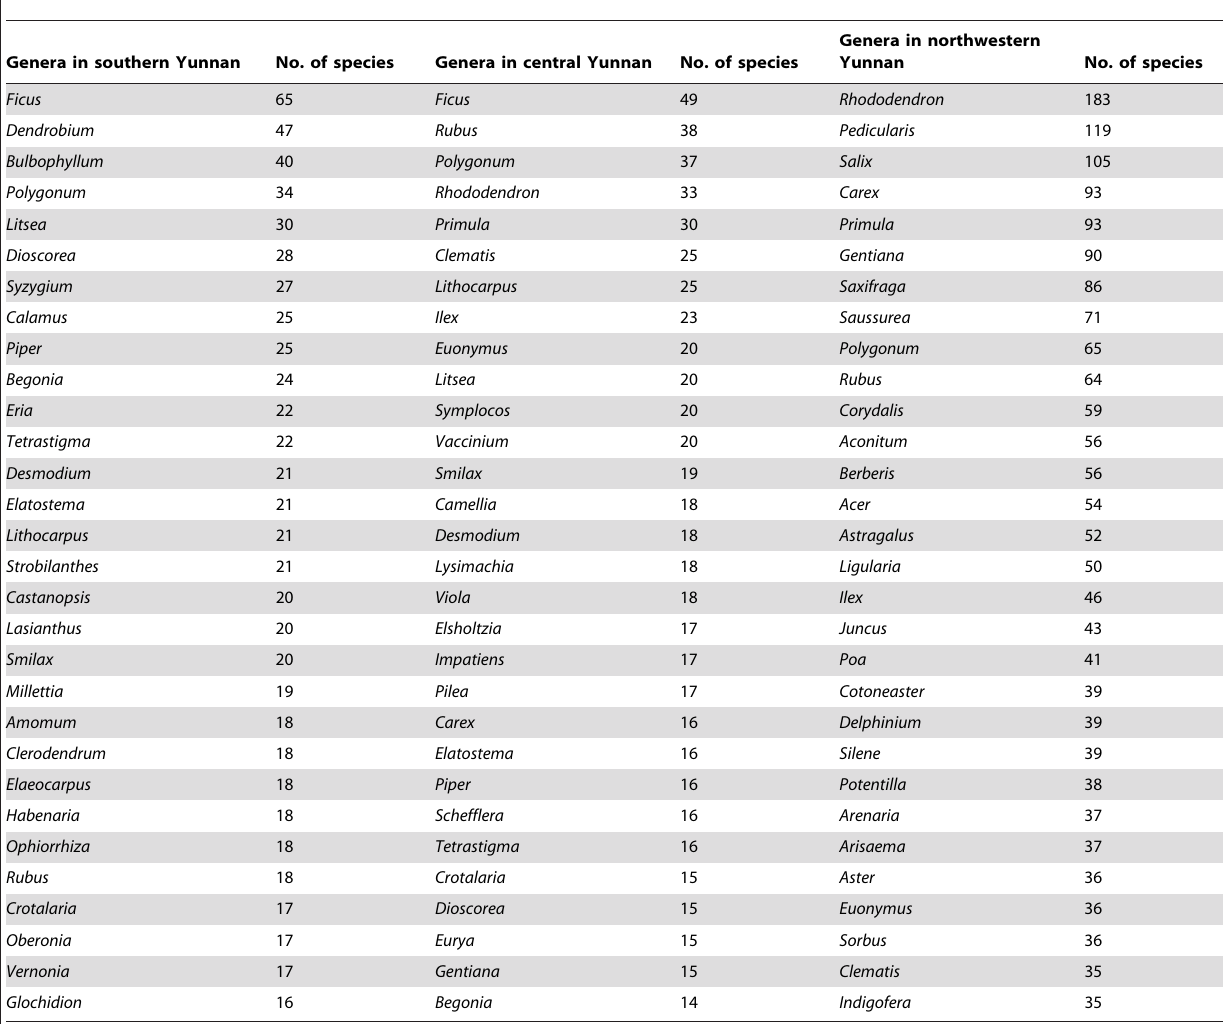
Table 2. Dominant genera ranking by species richness of these three compared floras.